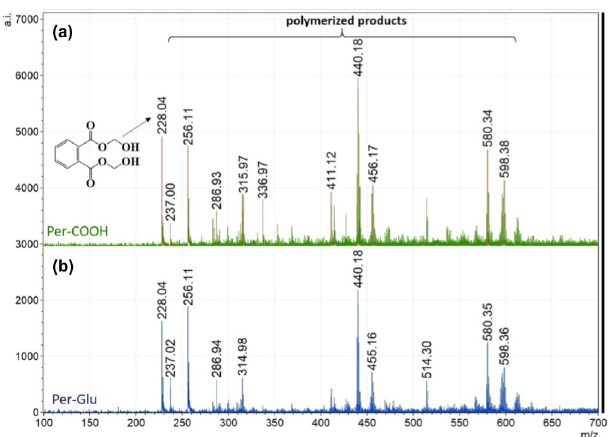
Figure 7. MALDI-TOF spectra of aqueous solutions of supernatants after the reaction of photodegra- dation of DHN assisted by the GO/Zn (OAc) 2 /glu-PDI ( a ) and GO/Zn (OAc) 2 /PA-PDI ( b ).